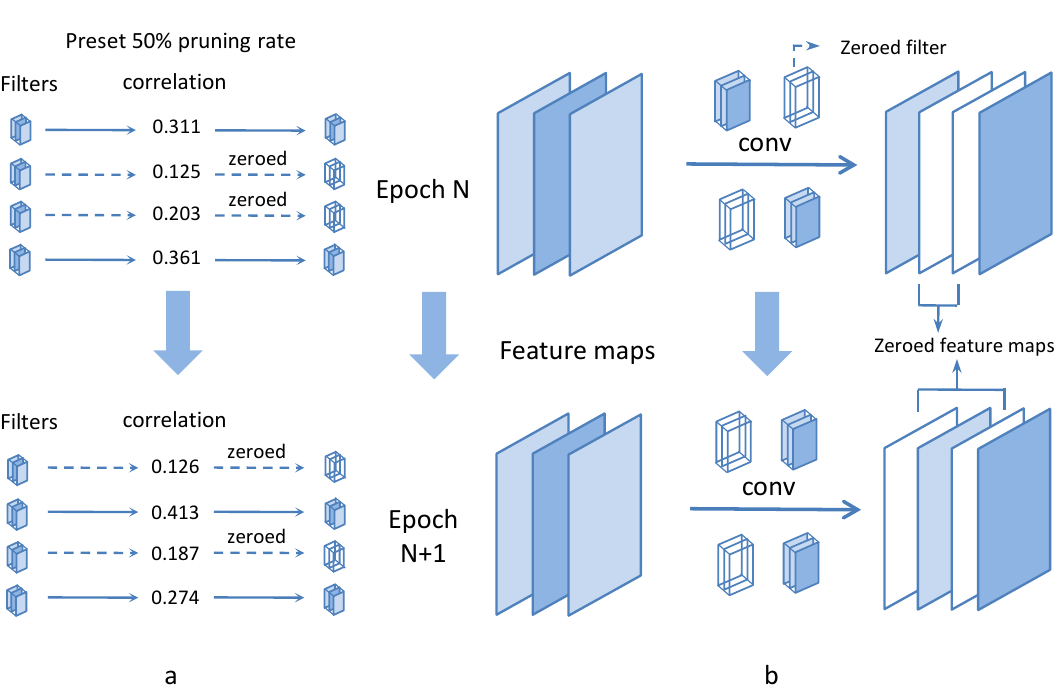
Figure 1. The overview of Filter Pruning with Attention Mechanism (PFAM). ( a ) Filter selection based on the correlation criterion. Note that the sum of the correlation values is 1 due to the output of softmax. The filters with less correlation values will be pruned based on the pre-set pruning ratio. ( b ) An example of filter pruning in convolutional layers. The pruned filters are allowed to be updated to non-zero during each training epoch prior to the next pruning stage to maintain the model